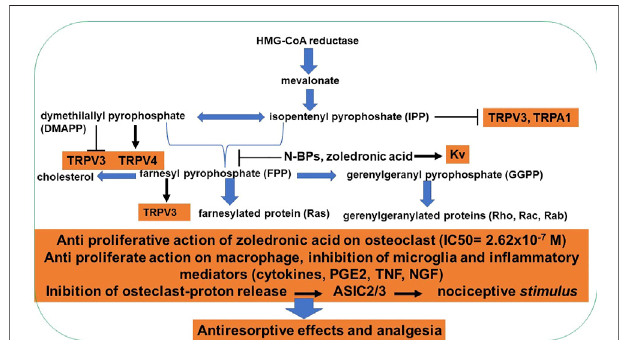
FIGURE 3 | Schematic diagram of the mechanism of action of second and third BPs on osteoclasts. Nitrogen-containing BPs can inhibit FPP synthase, preventing the synthesis of FPP and GGPP required for the prenylation of proteins that are crucial for osteoclast function and survival.InhibitionofFPPsynthasealsocausestheaccumulationofIPP,which is incorporated into the cytotoxic metabolite. The action of intermediate metabolites on TRP channels. Consequences of inhibition of farnesyl diphosphate synthase by N-BPs on the nociceptive pathways.